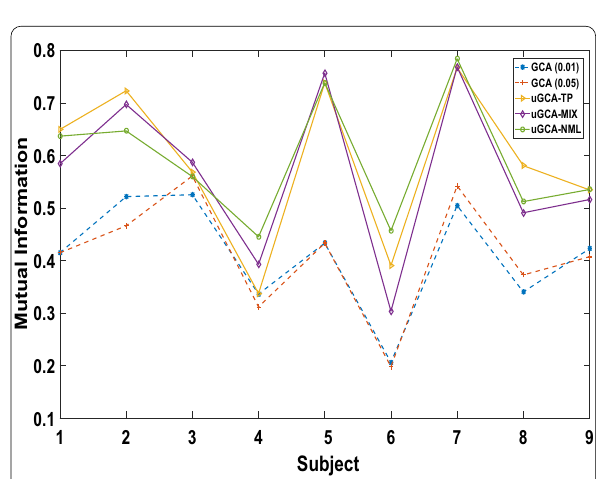
Fig. 5 Mutual information of the obtained mental arithmetic networks under two stimuli(visual stimulus and auditory